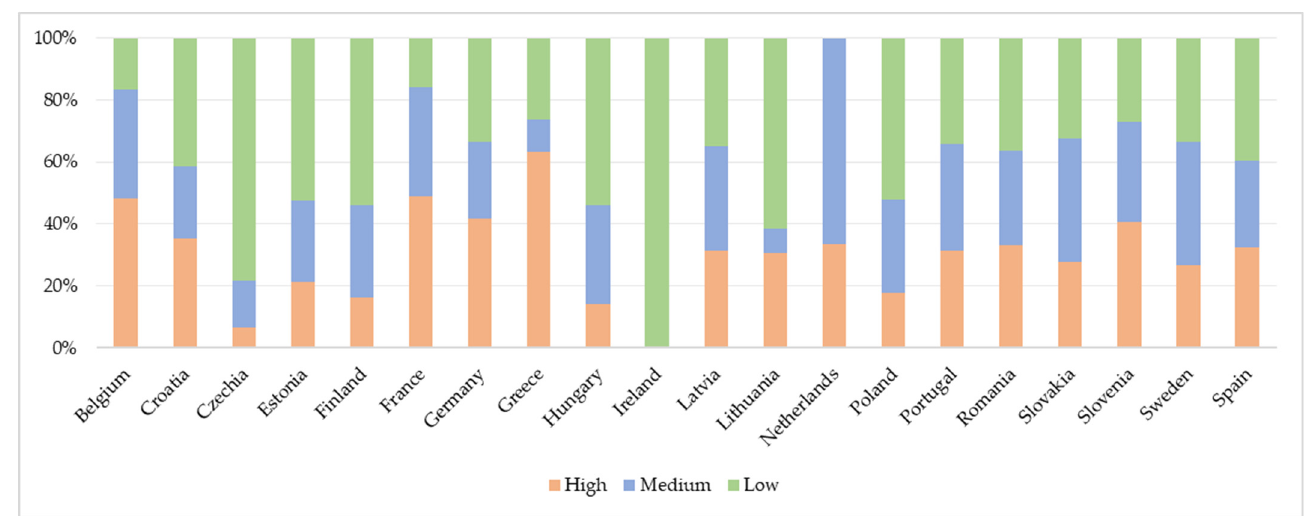
Figure 2. Solvency risk by country, 2011–2019. Source: authors’ calculations and representations.